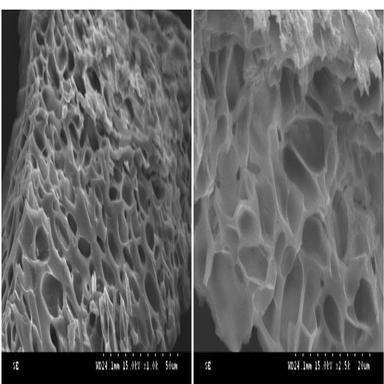
SEM images of grafted copolymer PG-AM.